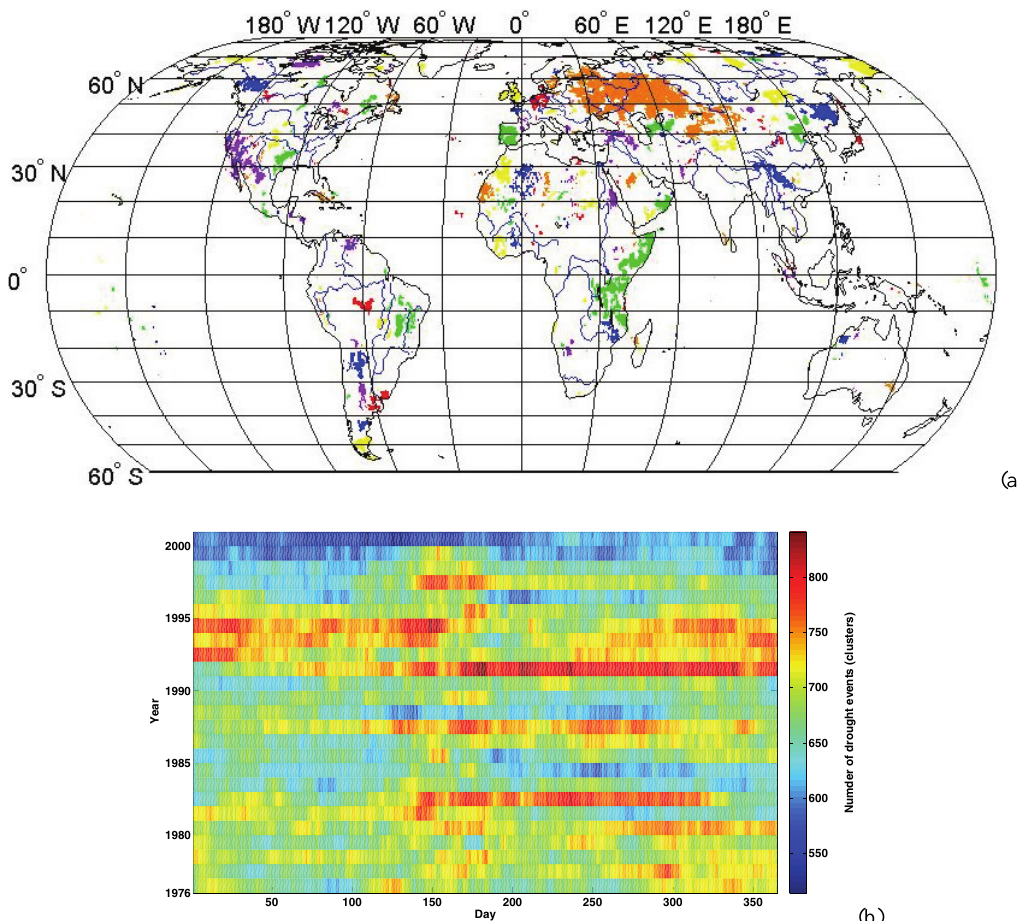
Fig. 10. Results of the CDA method applied for the analysis of number of drought clusters. (a) Drought clusters for 10 January 1976 (around 800 colors, each color represent a cluster and (b) color-coded table of the number of drought clusters on the whole